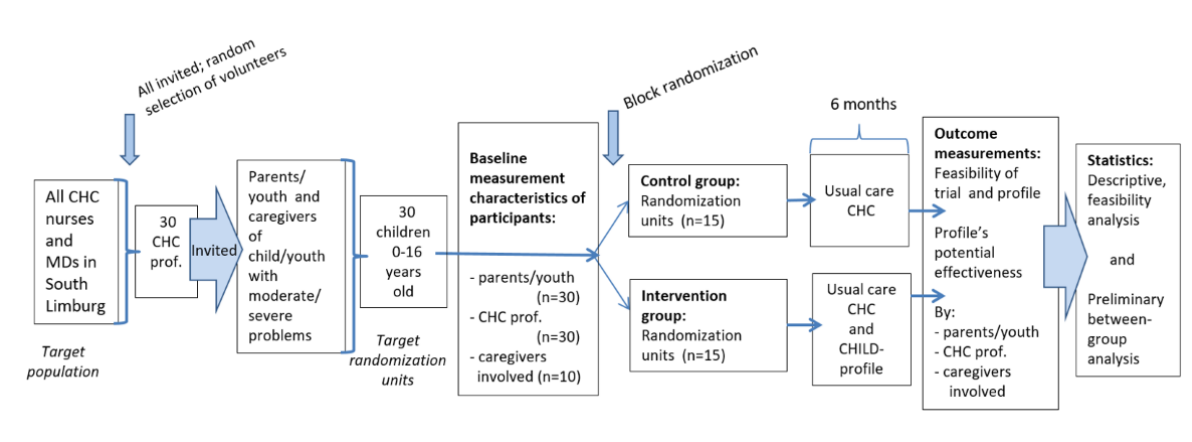
Figure 2. Flowchart of the randomized controlled trial's protocol. CHC: child health care; MD: medical doctor; prof: professional.